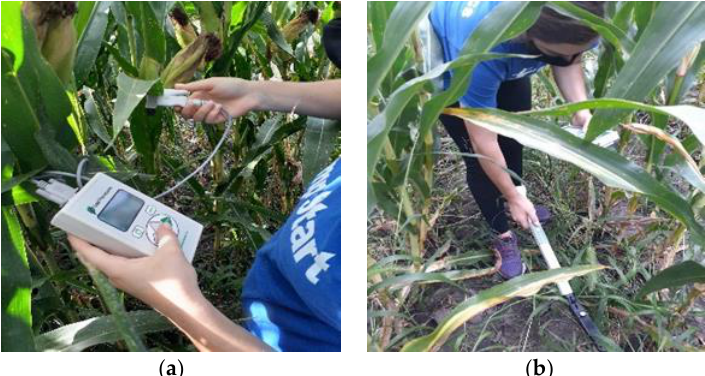
Figure 2. Ground reference measurements in F54 north on 28 August 2020 ( a ) stomatal conductance measurements from SC-1 leaf porometer; ( b ) LAI measurements from LAI-2200C plant canopy an- alyzer.